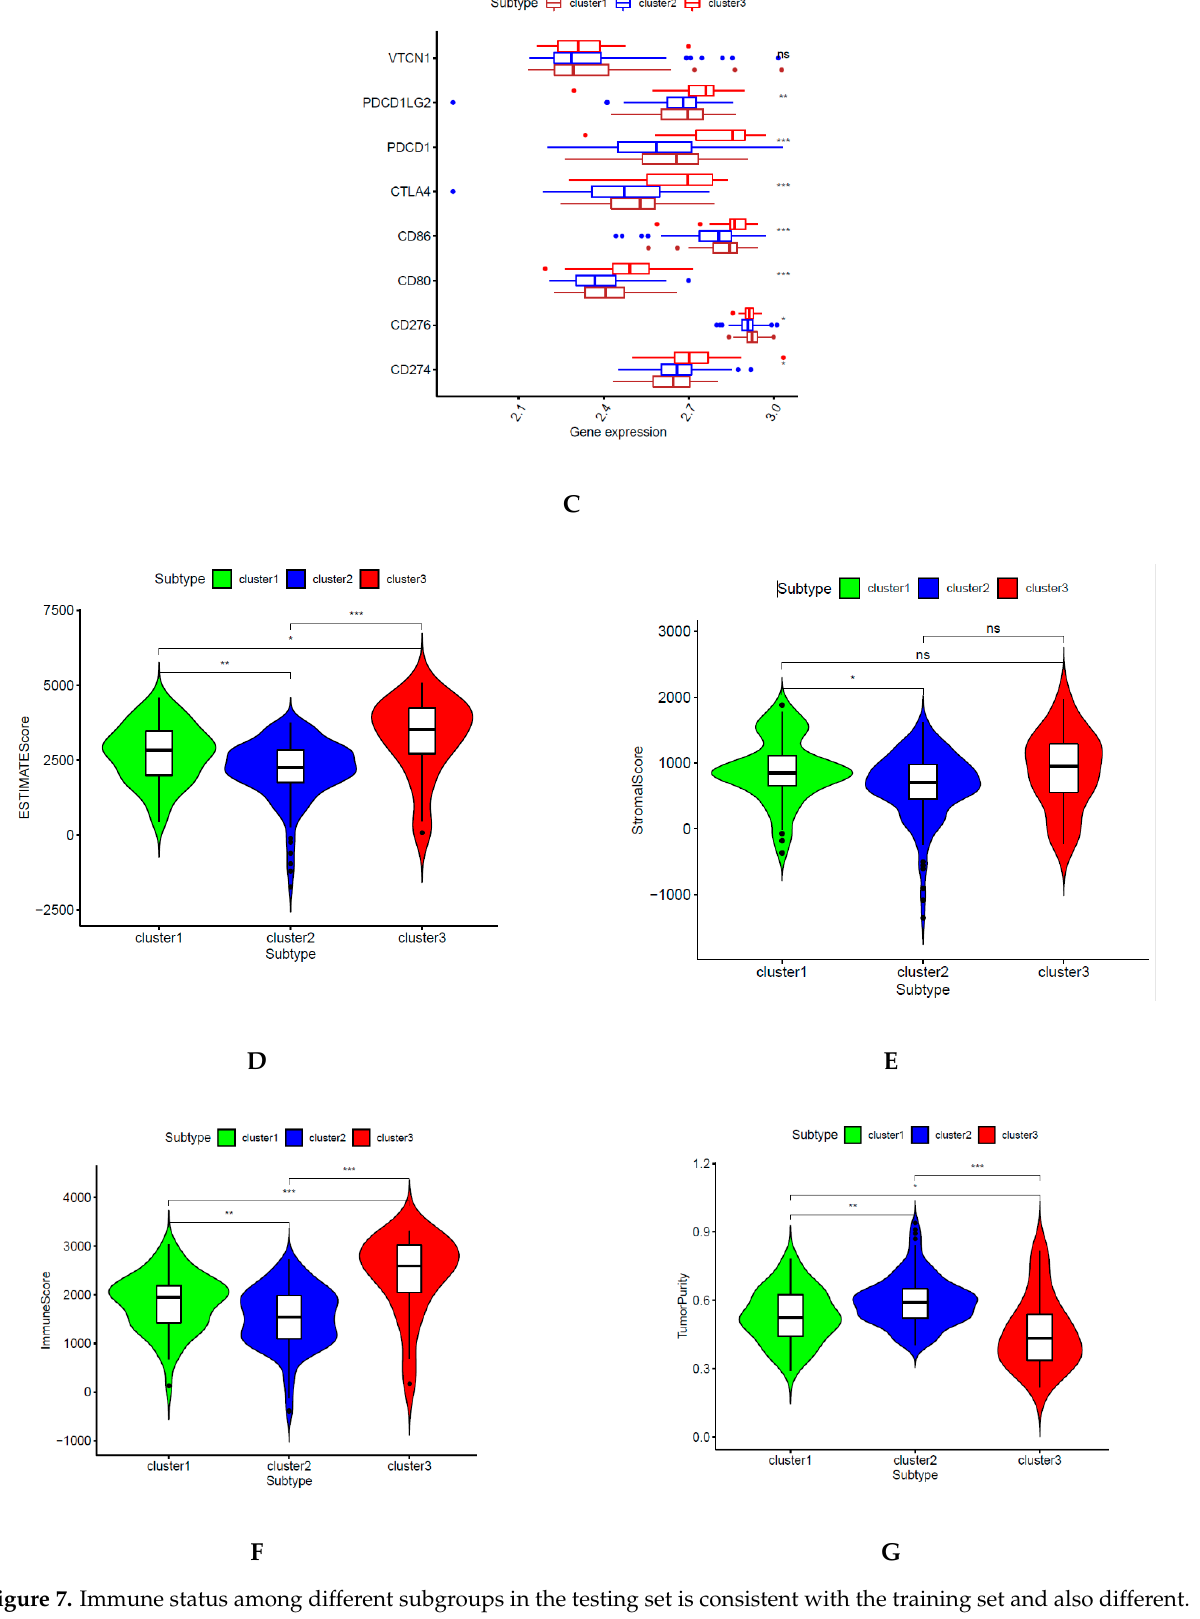
Figure 7. Immune status among different subgroups in the testing set is consistent with the training set and also different. ( A ) Immune infiltration level. ( B ) Immune infiltration cells. ( C ) Immune checkpoints. ( D – G ) TME. Three asterisks, two asterisks, and one asterisk represent a p -value less than 0.001, 0.01, and 0.05, respectively. NS represents no